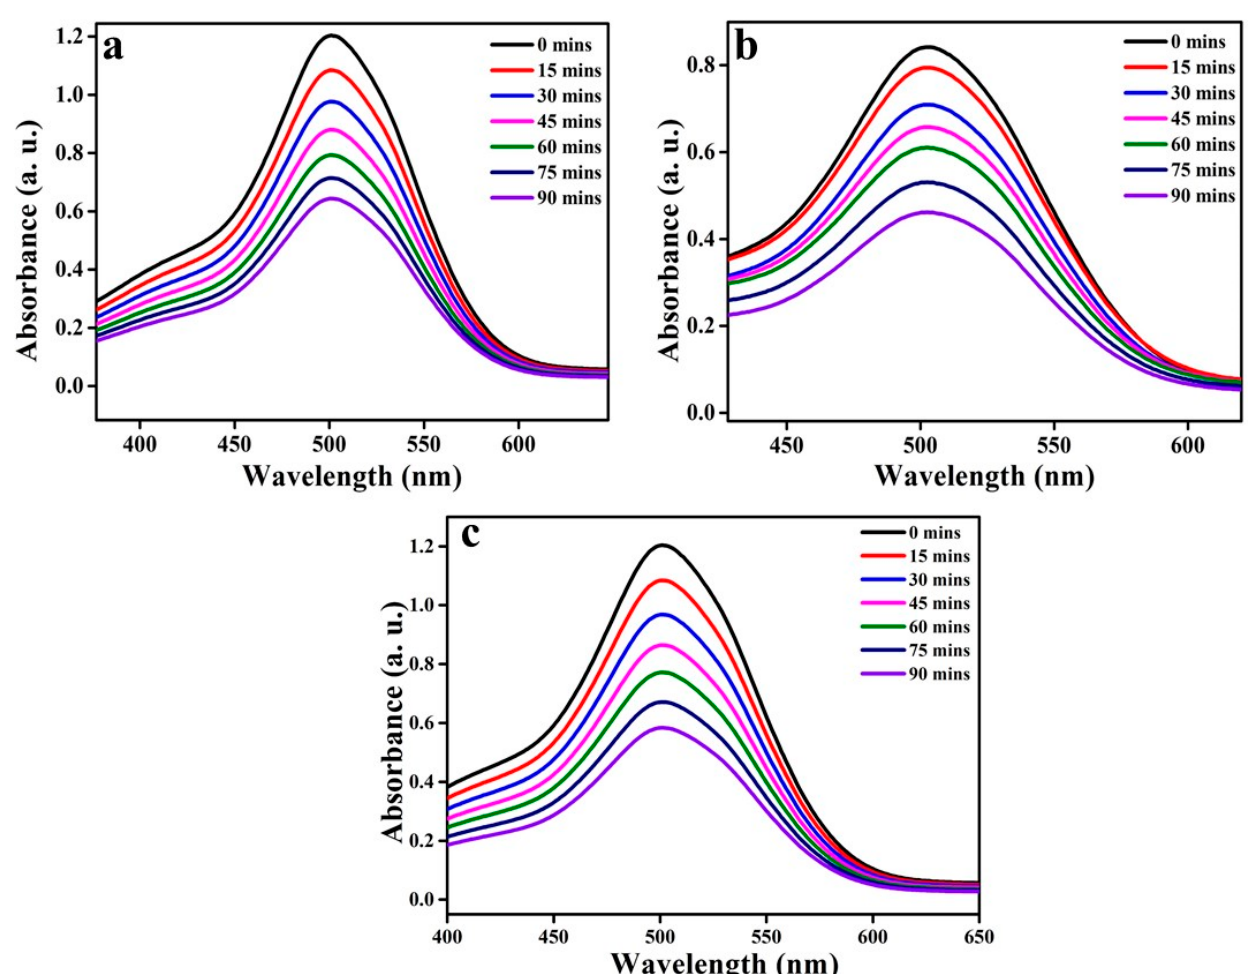
Figure 6. AR88 dye adsorption spectra with respect to time for the synthesized metal oxides (a). NiO, (b). CuO, (c). ZnO.